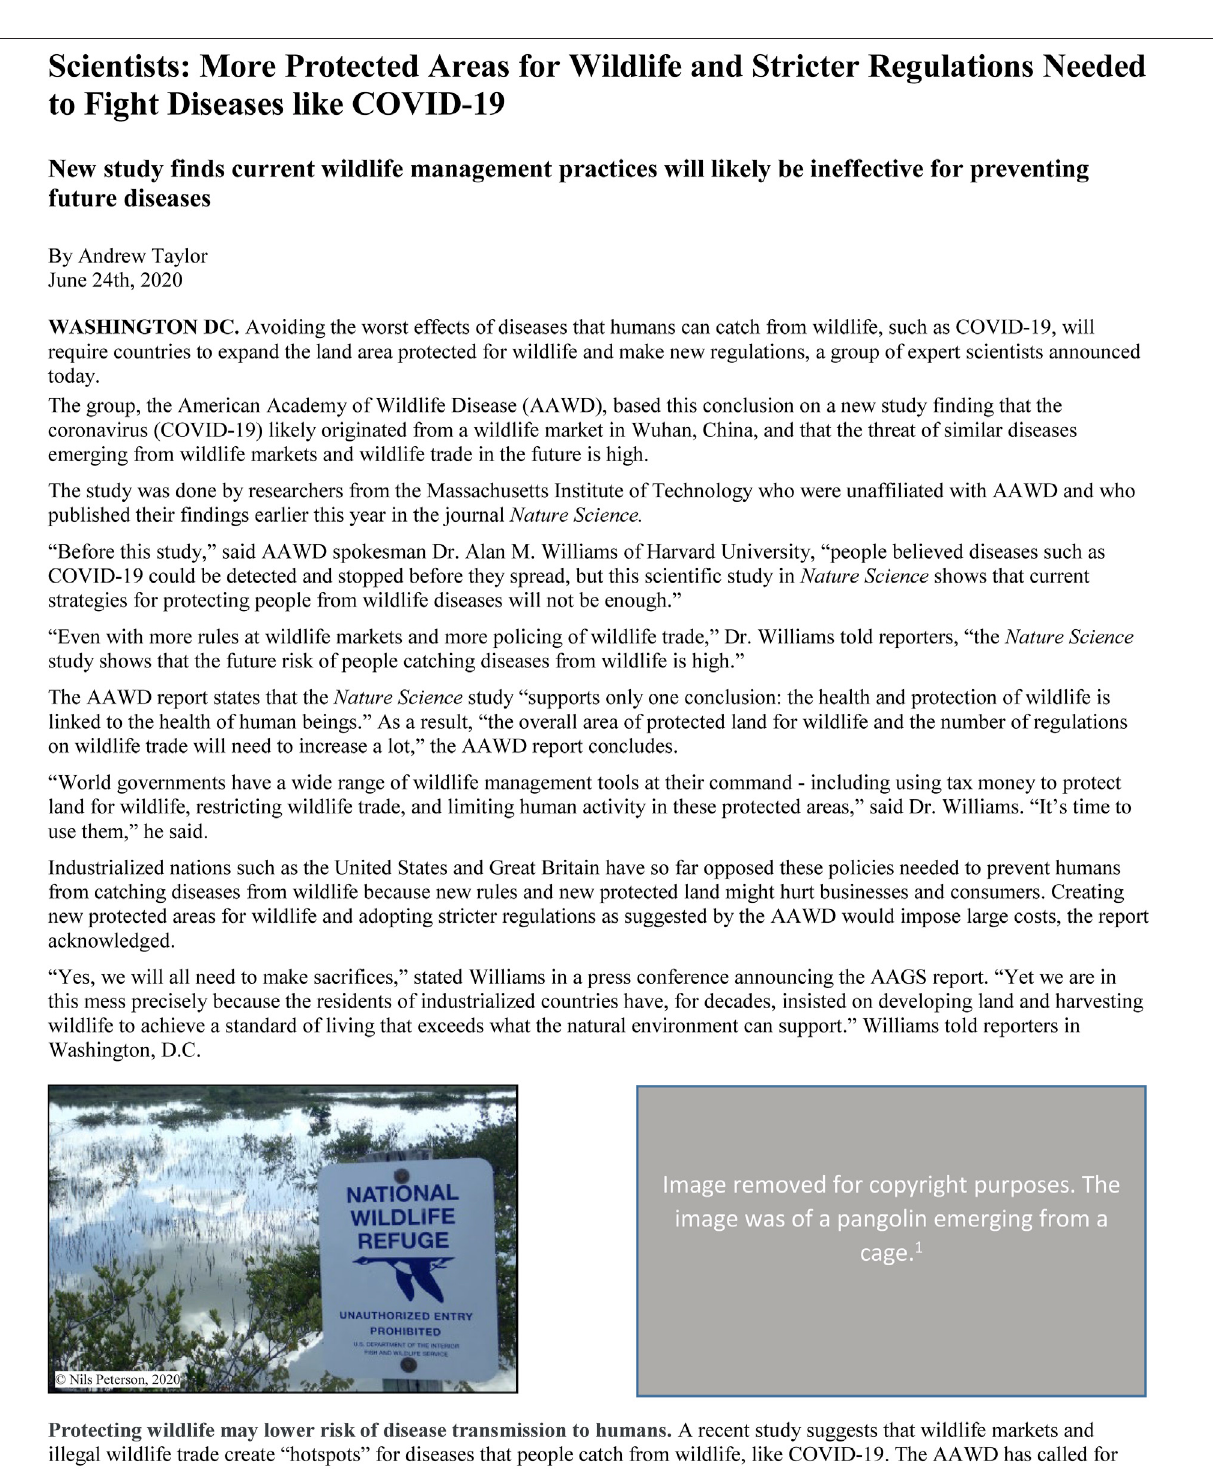
FIGURE2 | Regulatory framing of COVID-19 science highlighting the need for regulations and expansions of protected areas for wildlife to prevent the emergence andspreadofzoonoses.ModeledafterKahanetal.(2015),informationfromBonilla-Aldanaetal.(2020). 1 Linktoremovedimage:https://www.gettyimages.com/detail/ news-photo/malayan-pangolin-is-seen-out-of-its-cage-after-being-news-photo/51341736?adppopup (cid:1) true